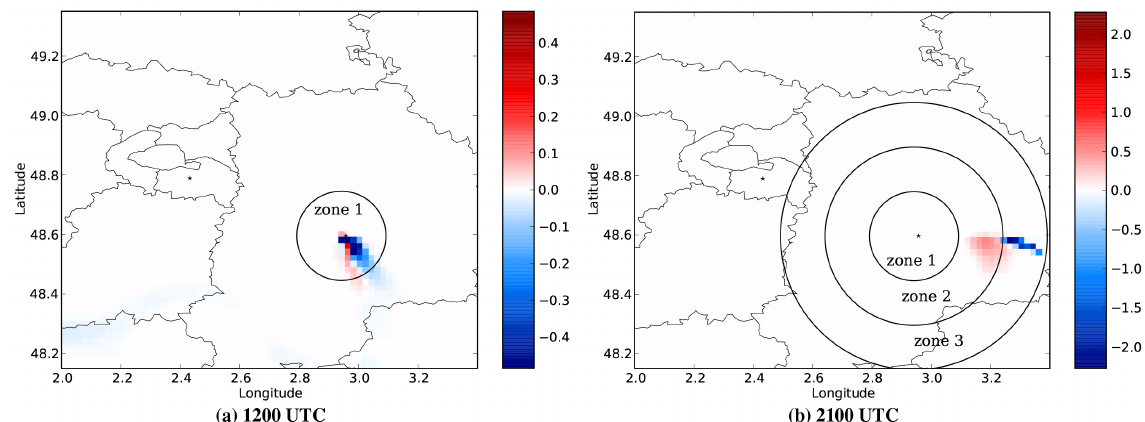
Fig. 8. Differences (PinG – PinG-SizeOnly) in the concentrations of NO x on 4 July 2009 (ppb): (a) 12:00UTC, (b) 21:00UTC. The plume trajectory from the Grandpuits refinery corresponds to the blue grid cells.